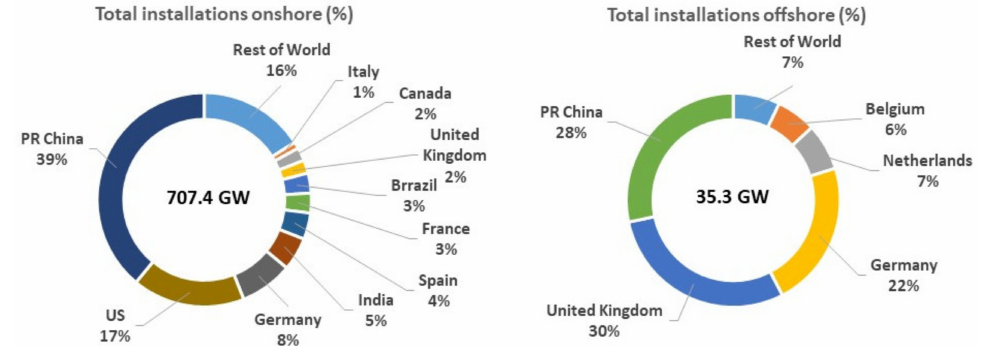
Figure 2. Total installed wind power onshore/offshore 2020. Global Wind Energy Council